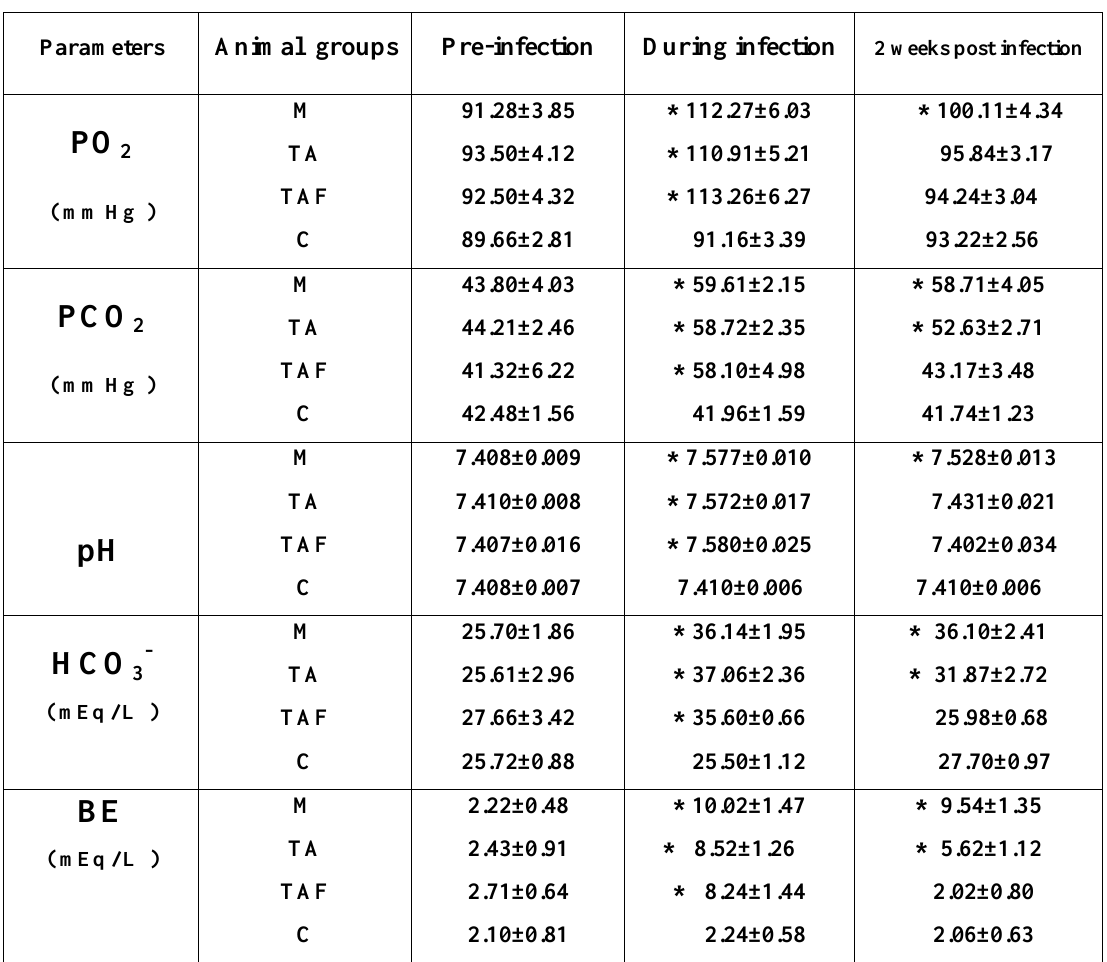
, PCO , bicarbonate (HCO 2 2 (BE) in mastitic cows (mean ±